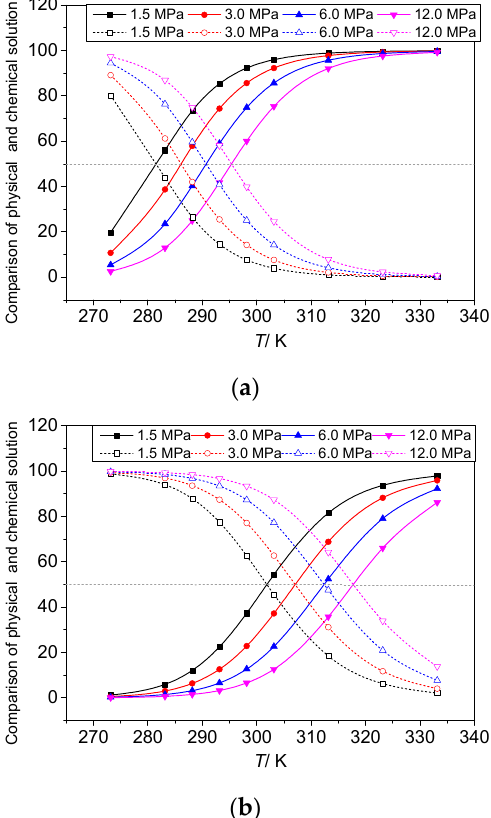
Figure 7. Proportional variation curve of the physical and chemical solubility of sulfur in the same system. ( a ) Gas 1; ( b ) Gas